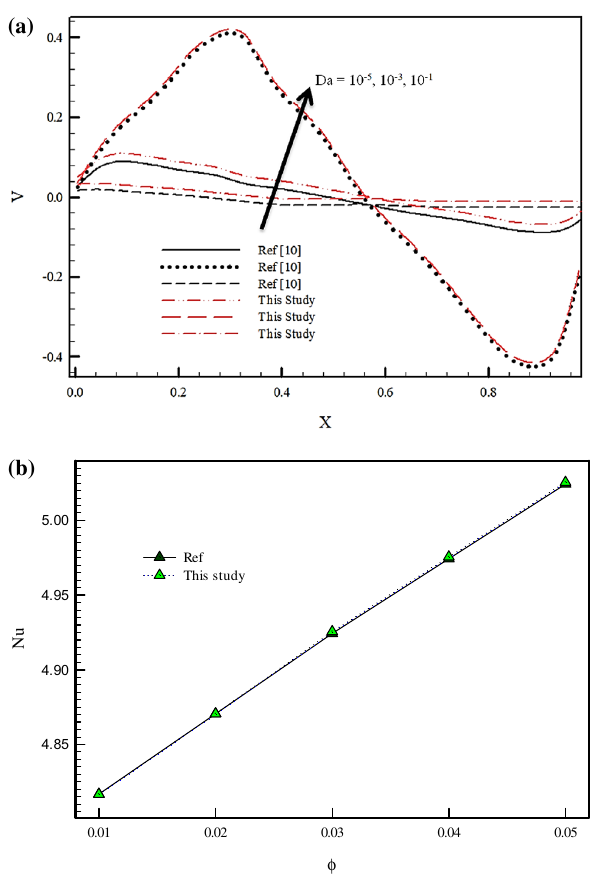
Figure 2. ( a ) Validation of present numerical code with Ref. 10 . ( b ) Validation of present numerical code with Ref. 20 .